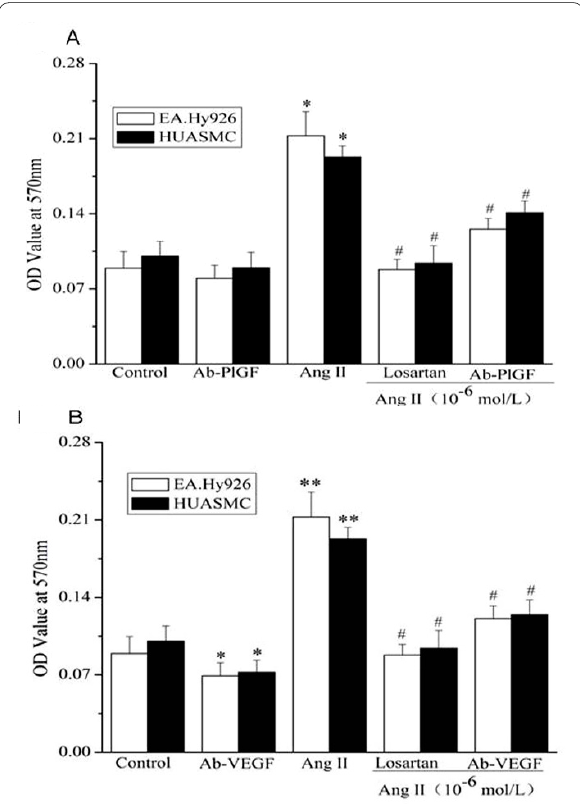
Figure 4 Molecular mechanisms involved in Angiotensin II-in- duced PlGF upregulation in EA.Hy 926 cells and HUASMCs . (A) Ef- fects of different inhibitors on the PlGF mRNA expression induced by Ang II by using Quantitative RT-PCR. Cells were pretreated with differ- ent inhibitors for 30 mins and stimulated with Ang II (10 -6 mol/L) for 24 hours, and PlGF mRNA expression was assayed by Q-PCR (n = 3 in each group). * P < 0.05 vs control cells. # P < 0.05 vs cells treated with Ang II alone. (B) Effects of different inhibitors on the PlGF protein expression induced by Ang II detected by using ELISA. PlGF protein contents in the cell culture media were assayed by ELISA (n = 3 in each group). * P < 0.05 vs control cells. # P < 0.05 vs cells treated with Ang II alone.